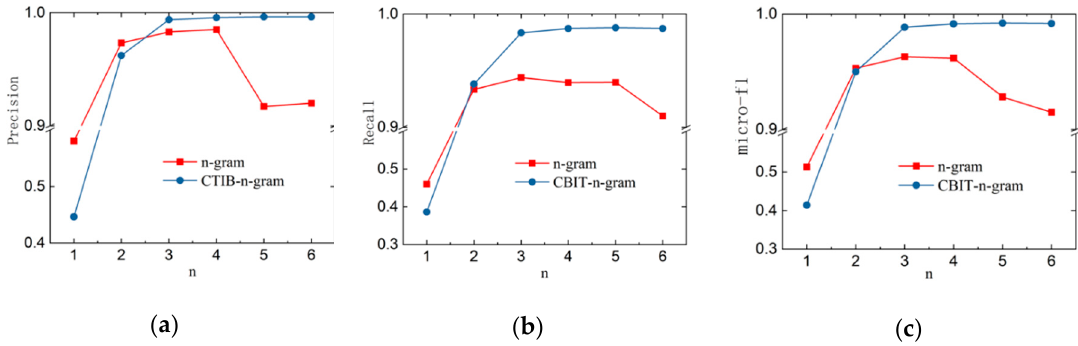
Figure 8. Comparing results obtained by the model using the standard n-gram method and the CTIB-n-gram algorithm, respectively. ( a ) Precision; ( b ) recall; and ( c ) micro-f1.